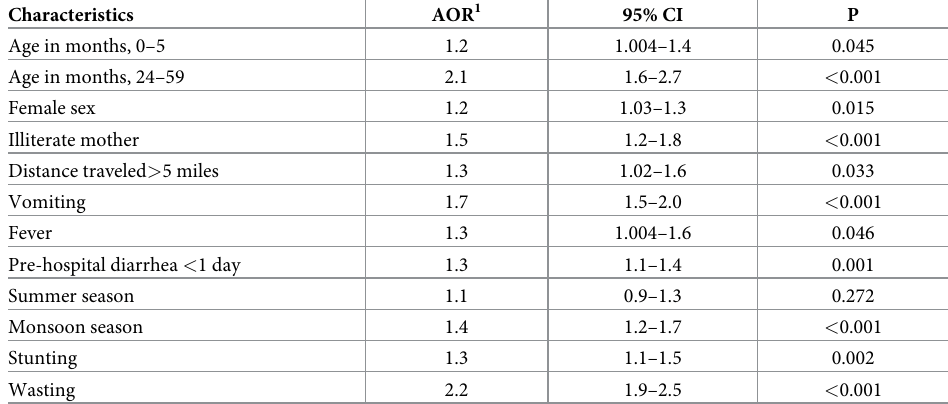
Table 3. Results of multiple logistic regression to explore the independent predictors of clinical dehydration among rotavirus-infected under-five children in Dhaka. Characteristics